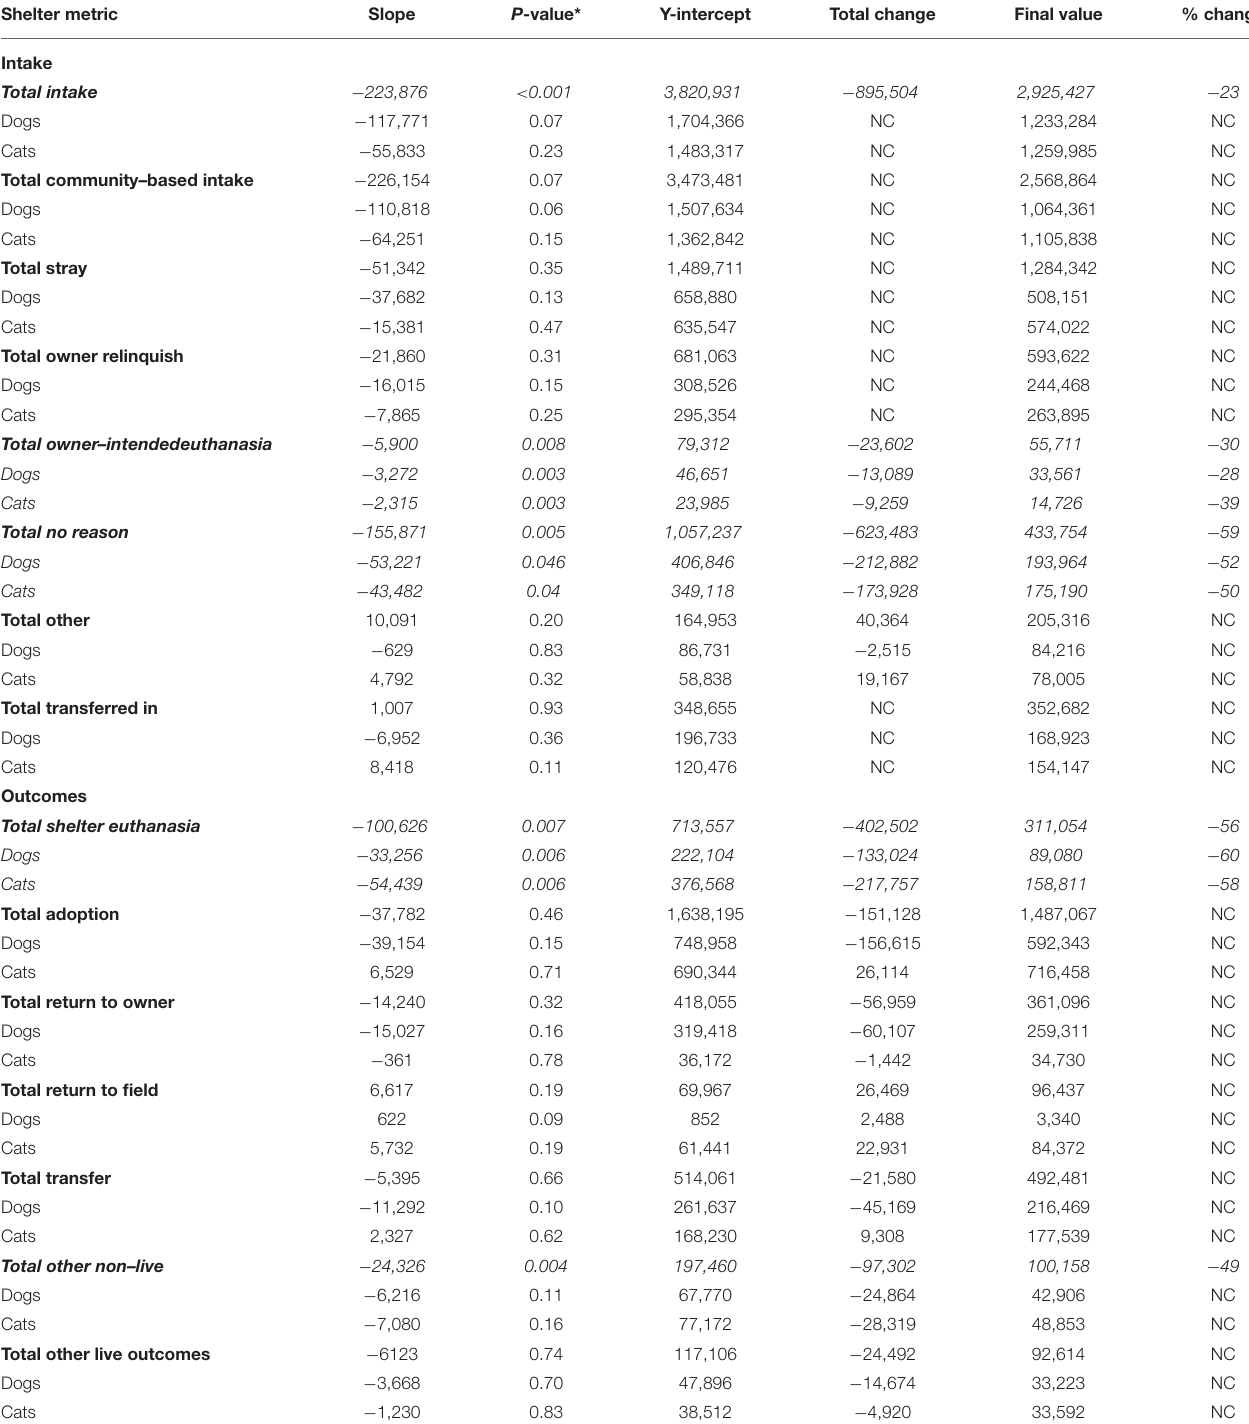
TABLE 1 | Results of linear regression analysis of total intake and outcome data reported by animal shelter organizations in the United States (2016–2020). Shelter metric Slope P -value* Y-intercept Total